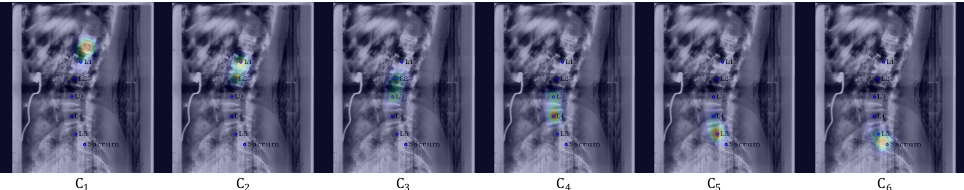
Figure 5. Failure example. Blue circles and labels denote the ground truth of each vertebra. From left to right, the confidence maps for the centers of L1, L2, L3, L4, L5, and the sacrum are displayed with the input images,